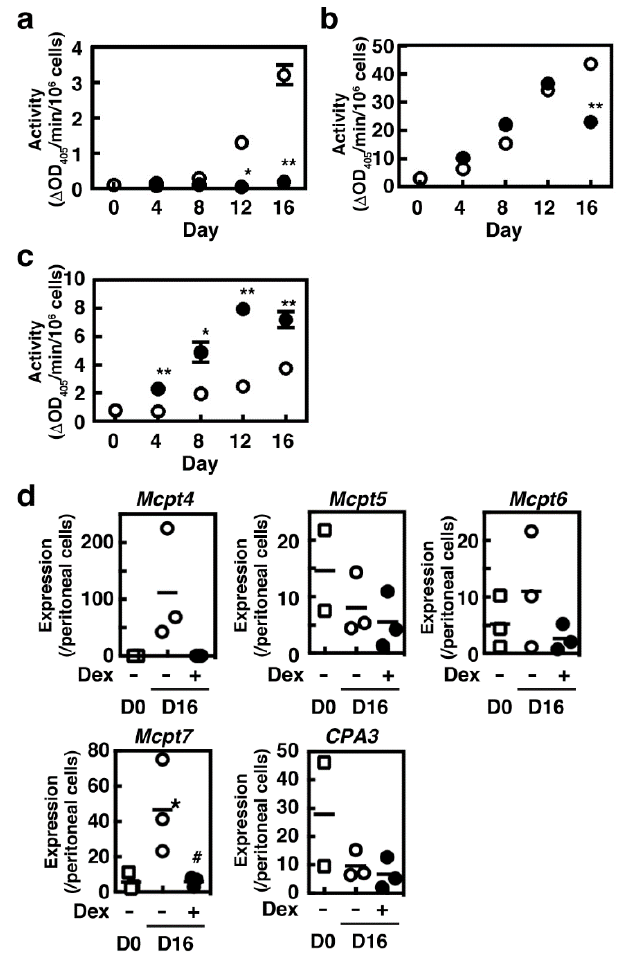
Figure 2. BMMCs were co-cultured with Swiss 3T3 fibroblasts in the presence (closed circles or columns) or absence (open circles or columns) of 1 µ M dexamethasone for 16 days as described in Materials and Methods. ( a – c ) Enzymatic activities of three kinds of granule proteases ( a ); chymotryptic activity, ( b ); tryptic activity, and ( c ); carboxypeptidase A activity) were measured. Values are presented as the means ± SEMs (n = 3). Values with * p < 0.05 and ** p < 0.01 are regarded as significant. ( d ) Expression levels of granule protease genes ( Mcpt4 , 5 , 6 , 7 , and CPA3 ) were determined by quantitative RT-PCR analyses. Values with * p < 0.05 (vs. D0) and # p < 0.05 (vs. D16, ( − )Dex) are regarded as